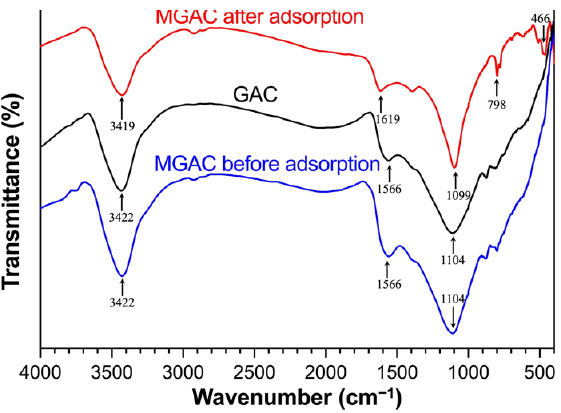
Figure 3. The FTIR spectra of GAC and MGAC before and after adsorption.